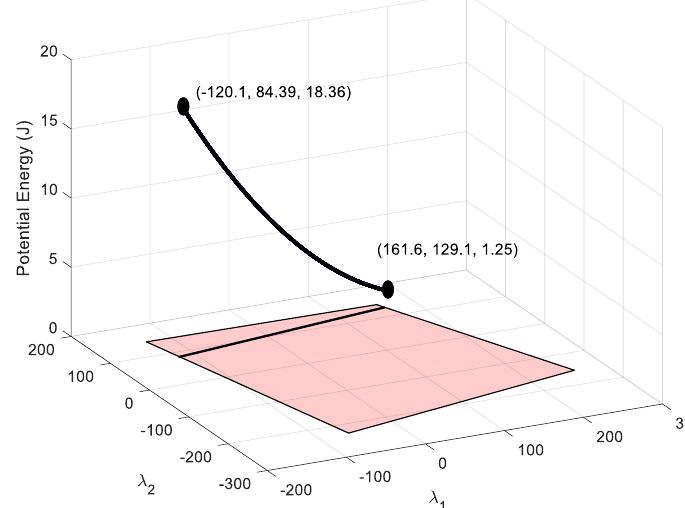
Figure 10. The black 3D curve represents the potential energy stored in cable 1 that can be achieved by maintaining the condition of setting a deformation in cable 8 of 0.2 m. The projection of this curve over the horizontal plane provides feasible nullspace variables. Coordinates are [ 𝛌 𝟏 , 𝛌 𝟐 , U 1 ].